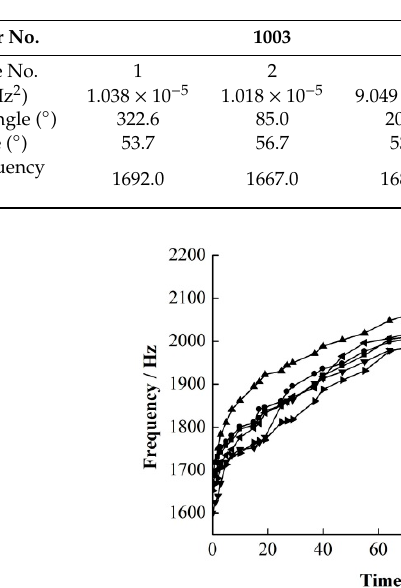
Table 6. Information from transducers embedded in the PDS No. 11 coal mine.